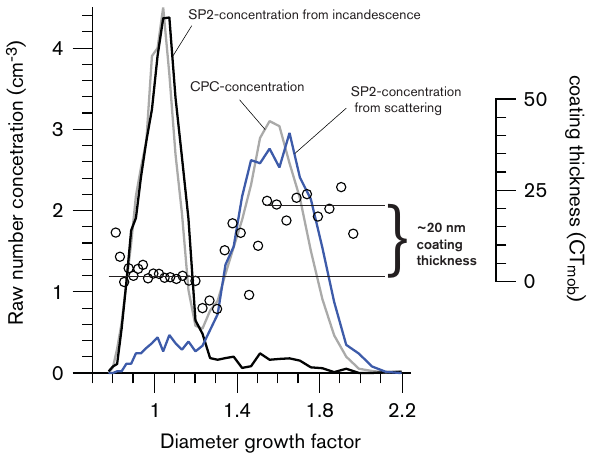
Fig. 2. Concentrations of total particles measured by the CPC, rBC and purely scattering particles measured by the SP2 and the mean mobility-derived coating thickness determined from SP2 mass measurements plotted as a function of growth